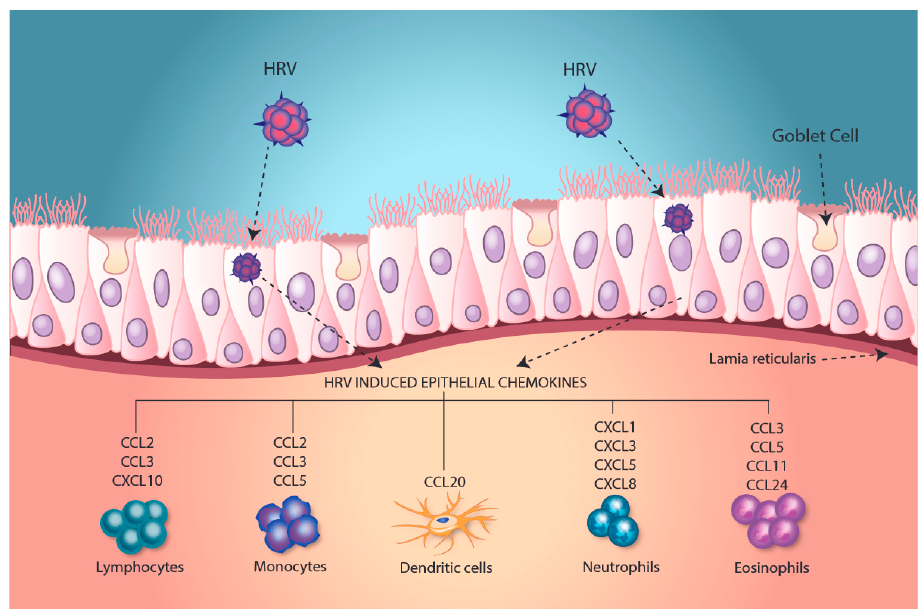
Figure 1. Human rhinovirus (HRV) infection of human airway epithelial cells can generate multiple chemokines that can recruit and/or activate numerous inflammatory cell